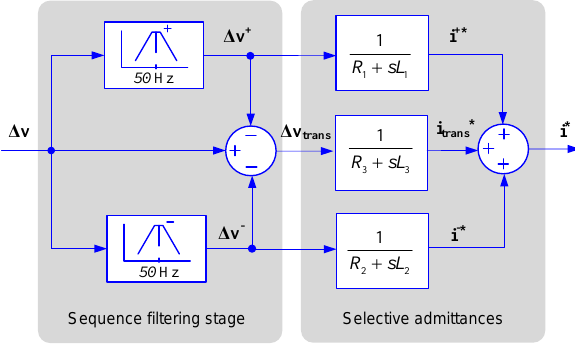
Figure 2. Virtual admittance block for positive- and negative-sequence current injection.